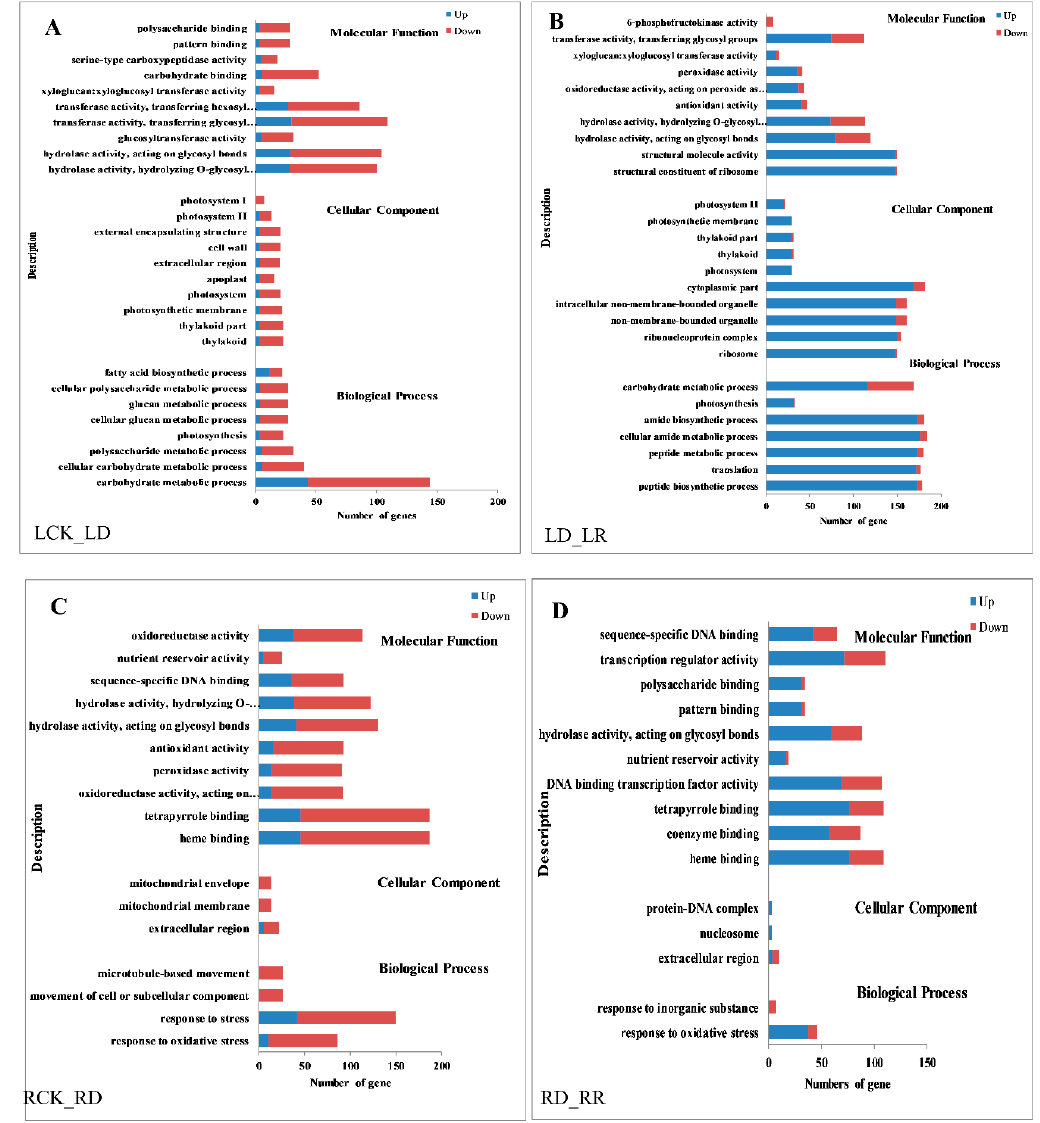
Figure 5. Gene ontology (GO) enrichment of DEGs in response to drought and rehydration in Jigu 16 foxtail millet. ( A ) GO enrichment of DEGs in leaves between watered control (LCK) and drought (LD). ( B ) GO enrichment of DEGs in leaves between drought (LD) and re-watering (LR). ( C ) GO enrichment of DEGs in roots between watered control (RCK) and drought (RD). ( D ) GO enrichment of DEGs in roots between drought (RD) and re-watering (RR). Blue columns indicate the numbers of upregulated genes, while red columns indicate numbers of downregulated genes. The threshold for di ff erential expression was set at log 2 fold-change > 1 and FDR ≤